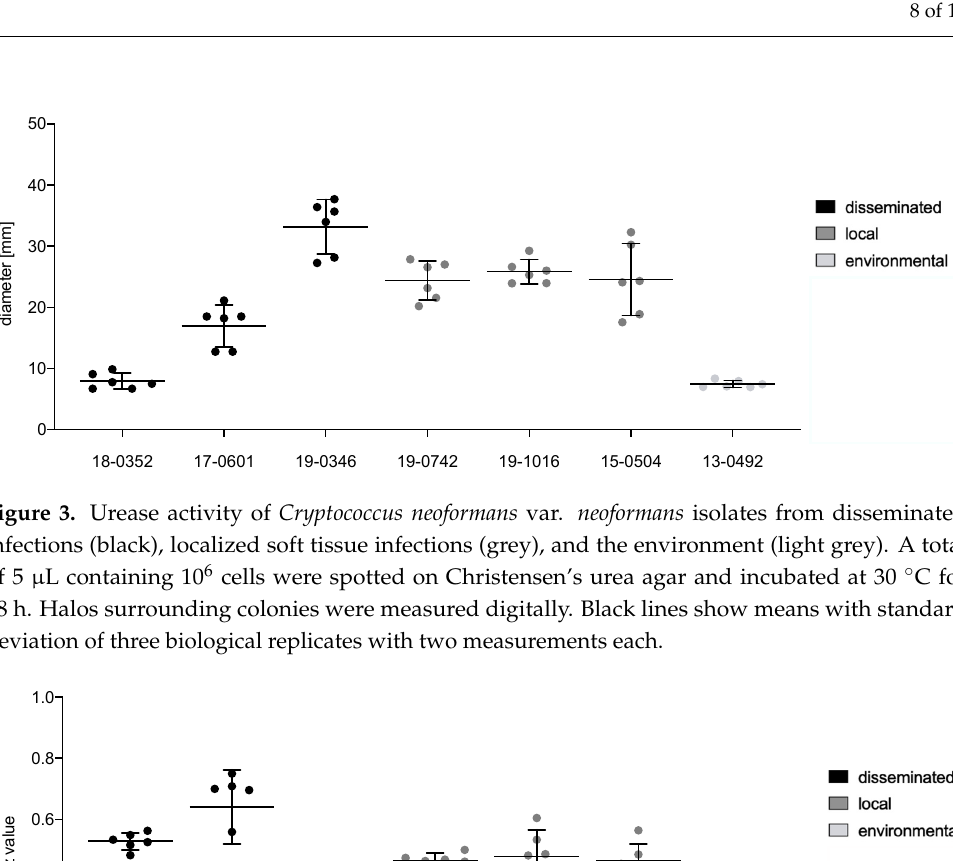
Figure 2. Capsule ( A ), cell body ( B ) and total cell size ( C ) of C. neoformans var. neoformans isolates from disseminated infections (black), localized soft tissue infections (grey), and the environment (light grey). Cells were incubated in minimal medium at 30 °C for 24 h. Cells were stained with India ink and measured digitally. Black lines show means with standard deviation of 20 measured cells per isolate. Dots show individual data points.